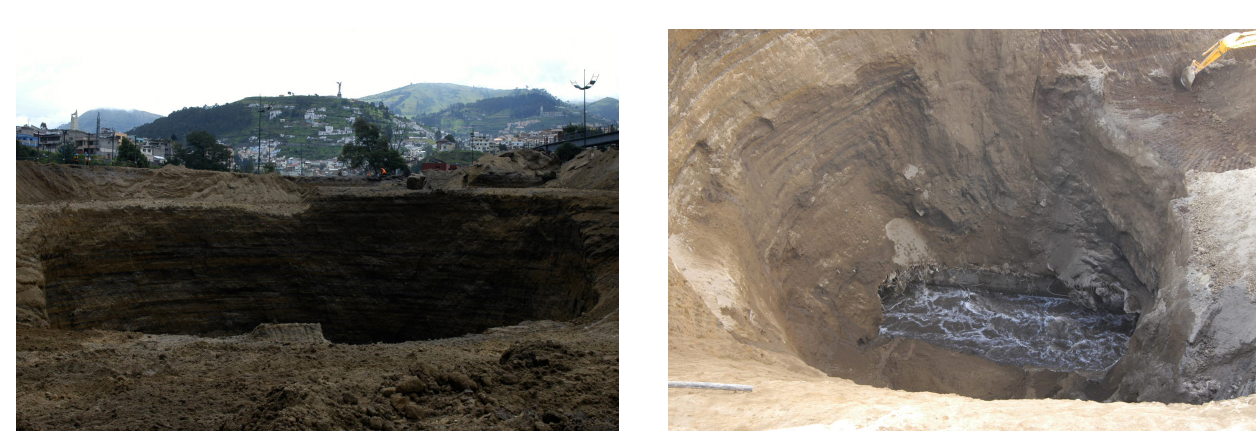
Figure 3. Panoramic view of the final stage of the sinkhole at El Trébol. On the background the Panecillo volcanic dome.